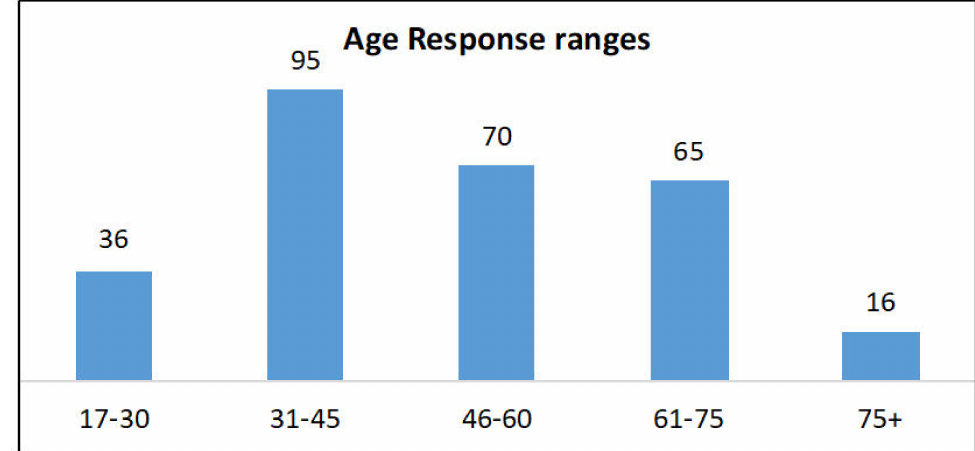
Figure 15. Number of survey responses for each age group.